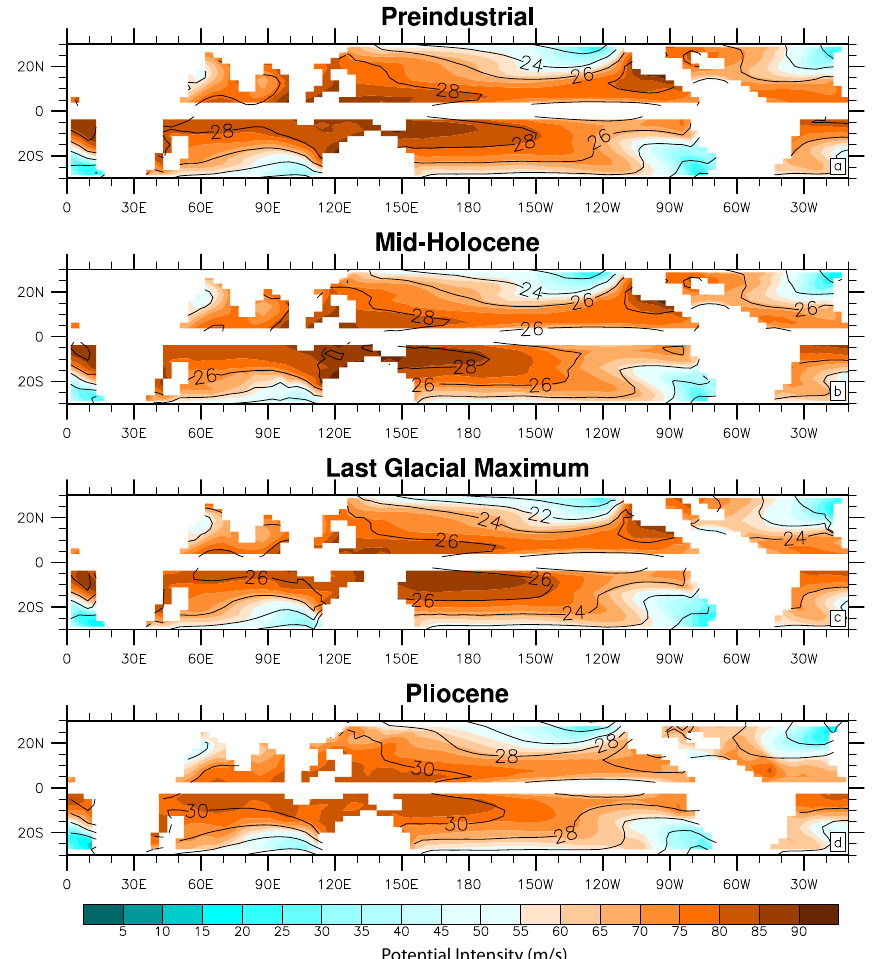
Figure 1. Sea surface temperature (contour lines) and potential intensity in the Northern Hemisphere (NH) during July–October (JASO) and Southern Hemisphere (SH) during January–April (JFMA) for (a) the preindustrial control, (b) Pliocene, (c) LGM and (d) mid-Holocene. Units are SST ( ◦ C) and potential intensity (ms − 1